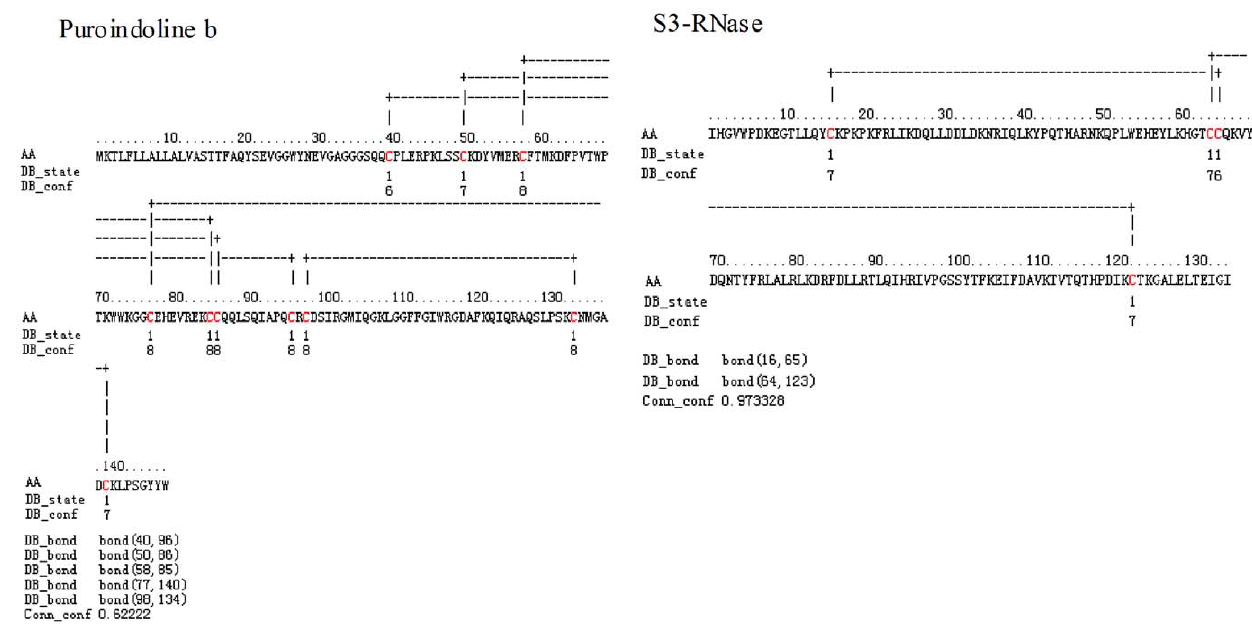
Figure 4. The predicting results of disulfide bonding state of some differential proteins. AA, amino acid sequence; DB_state, predicted disulfide bonding state (1=disulfide bonded, 0=not disulfide bonded); DB_conf, confidence of disulfide bonding state prediction (0=low to 9=high); DB_bond, position in sequence of a pair of cysteines predicted to be forming a disulfide bridge; Conn_conf, confidence of connectivity assignment given the predicted disulfide bonding state (real value in